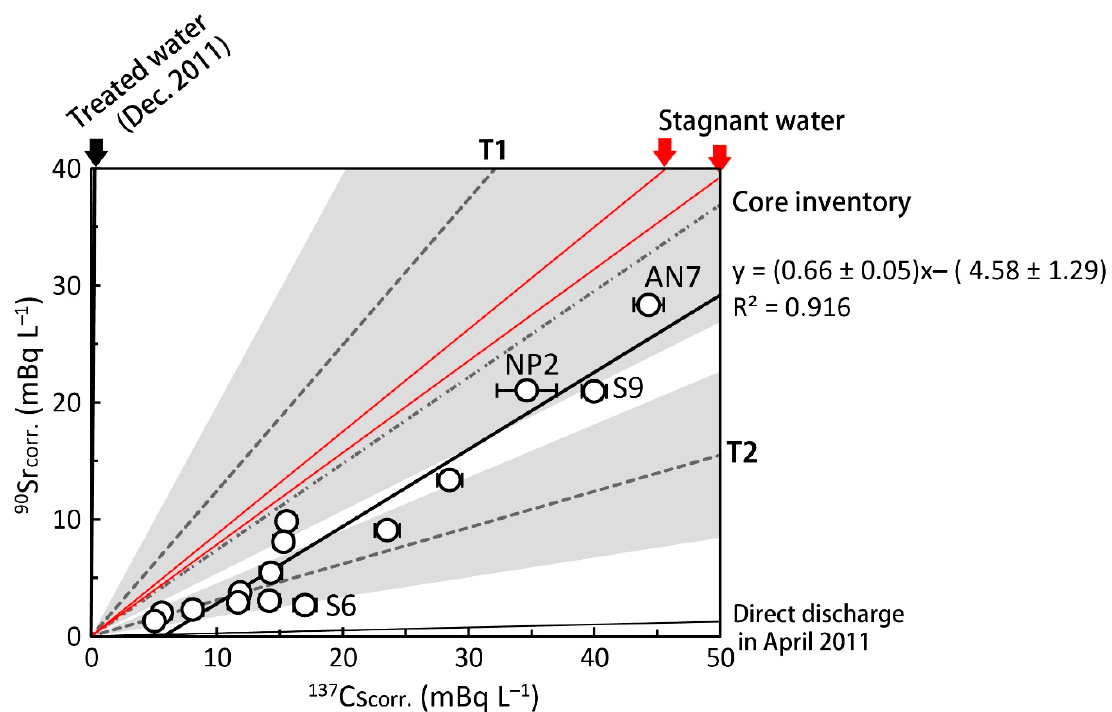
Figure 5. FDNPP site-derived 90 Sr and 137 Cs activities in surface seawater with 90 Sr / 137 Cs ratio for possible sources. The lower and upper red solid lines show 90 Sr / 137 Cs ratios for stagnant water in the reactor building in July 2013 (0.78) and August 2013 (0.88), respectively [6]. Core inventory (0.74) was estimated by the ORIGEN2 code [2]. Shaded areas were averaged monitoring data at T1 (1.25 ± 0.71) and T2-1 (0.31 ± 0.14) sites from January 2013 to October 2013.